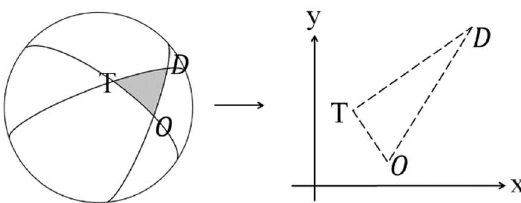
Figure 2. Transformation from a spherical Earth's surface to a 2D plan.